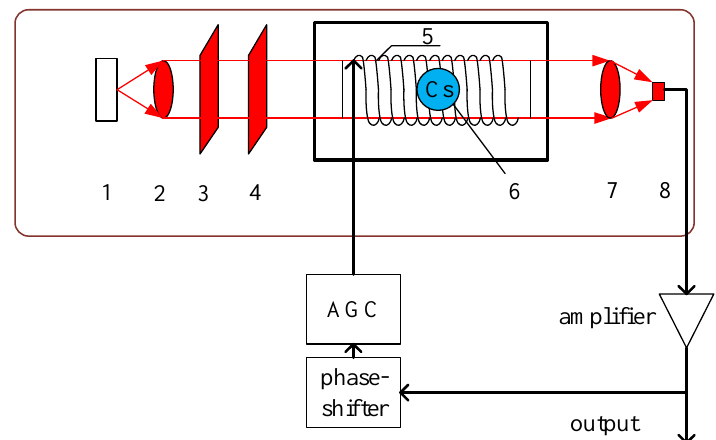
Figure 1. Sketched view of an optically pumped cesium magnetometer with ( 1 ) lamp, ( 2 ) lens, ( 3 ) filter, ( 4 ) polarizer, ( 5 ) radio frequency (RF) coil, ( 6 ) gas cell, ( 7 ) lens, ( 8 ) photo detector.